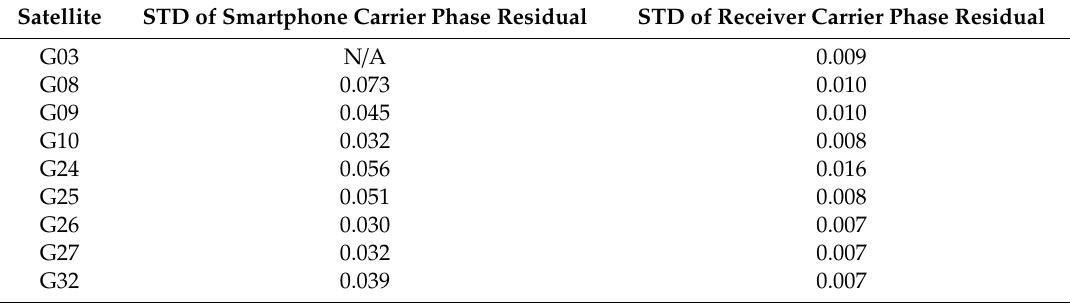
Table 5. Standard deviation of carrier phase residuals of smartphone and receiver (m).